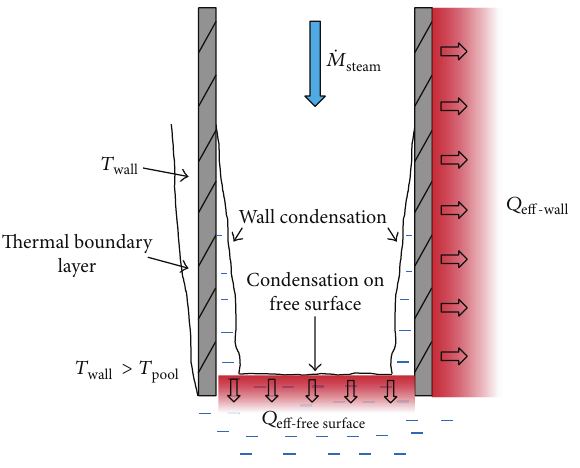
Figure 5: Condensation inside the blowdown pipe during steam